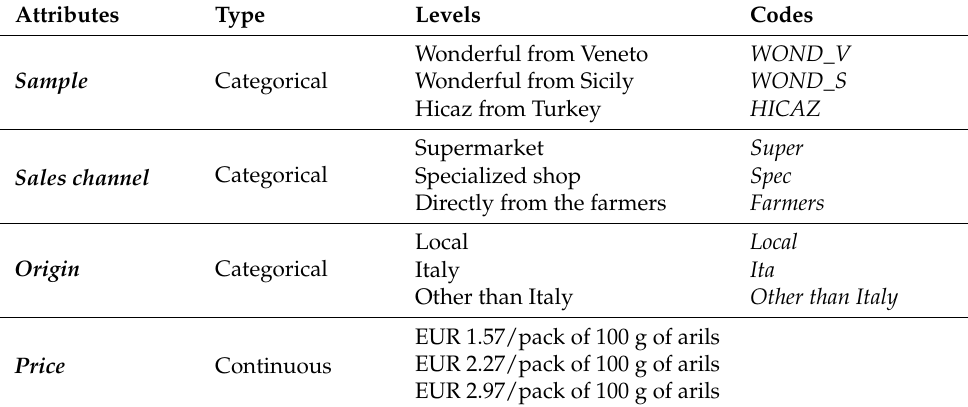
Table 1. Description of DCE attributes and